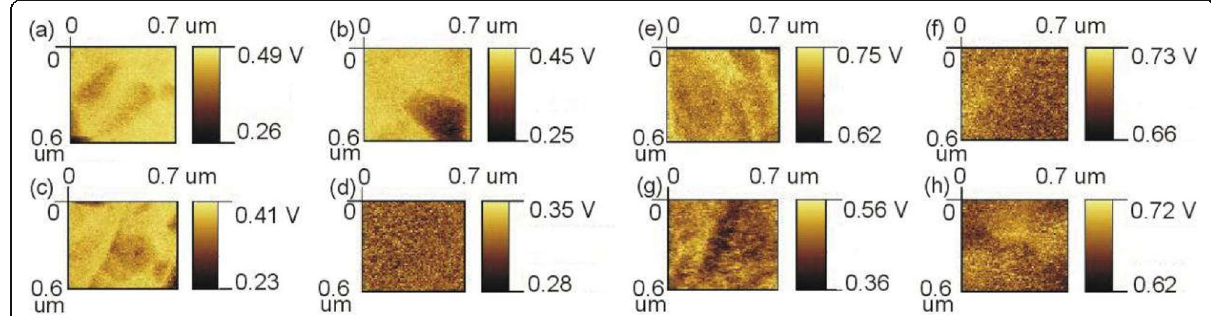
Fig. 9 KPFM images of Sb 2 S 3 of 1 h ( a ), 1.5 h ( b ), 2 h ( c ), and 3 h ( d ) and P3HT on Sb 2 S 3 of 1 h ( e ), 1.5 h ( f ), 2 h ( g ), and 3 h ( h ) under white light illumination from FTO glass, respectively. i , j The corresponding SP distributions of Sb